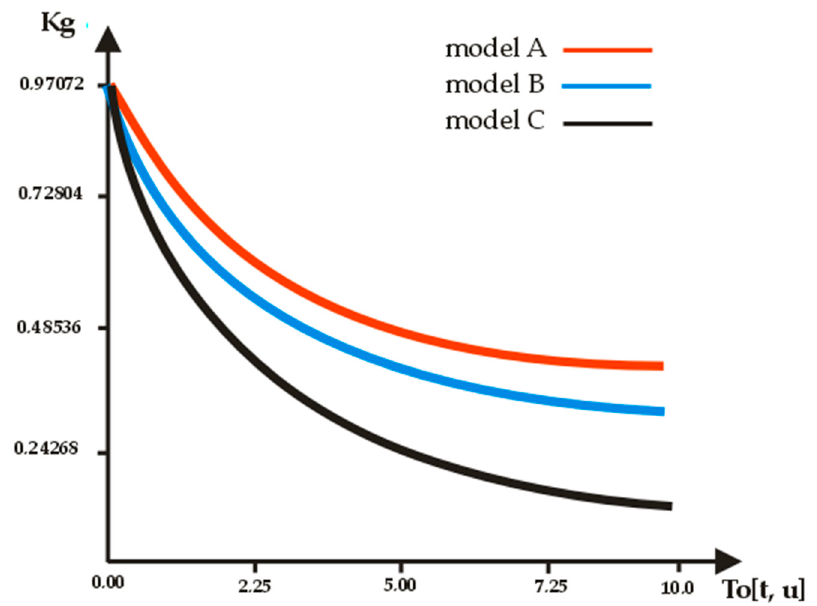
Figure 3. The graph of the K g (t) readiness function for the tested wind farm equipment models (A, B, and C) throughout the operation, where: T o is the object’s simulation test time and t, u is the process’s operational time units.